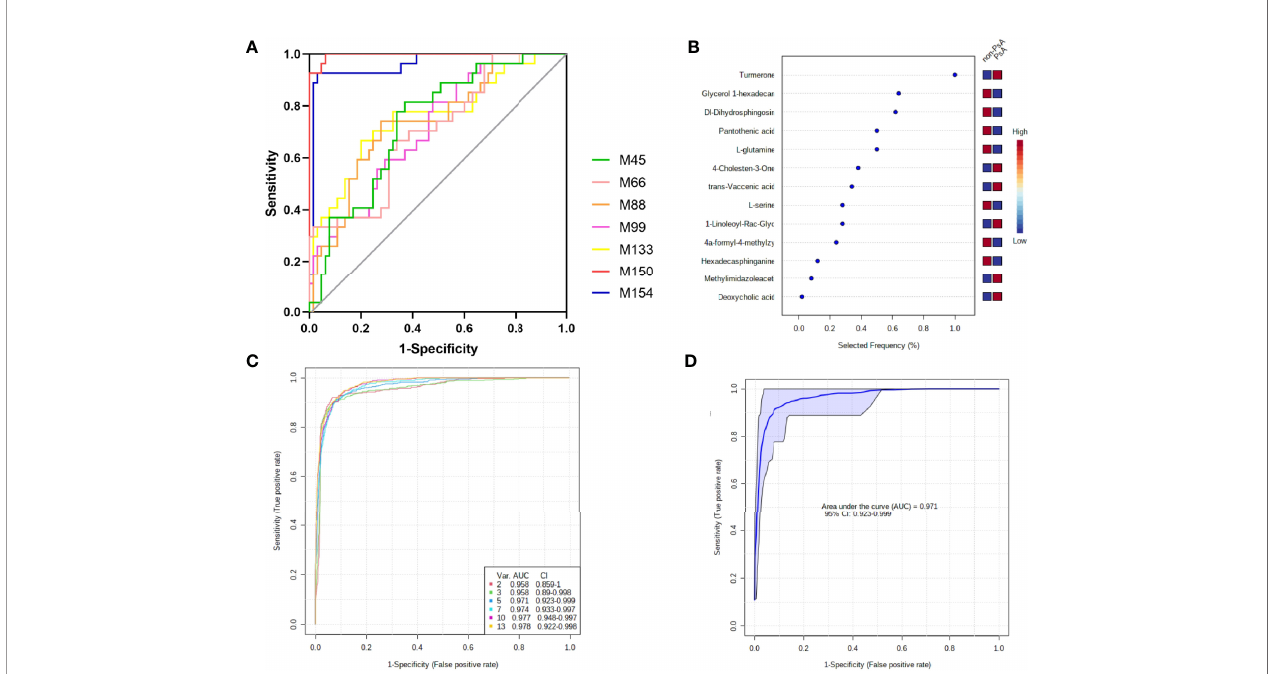
FIGURE 5 | Diagnostic performance of the biomarker model for PsA diagnosis. (A) ROC curve analysis of 7 fecal metabolites with AUC >0.7; (B) The selected frequency of 13 signi fi cant features in SVM model; (C) SVM classi fi er performance for classifying PsA versus non-PsA metabolites; (D) ROC curve for 5 fecal microbial